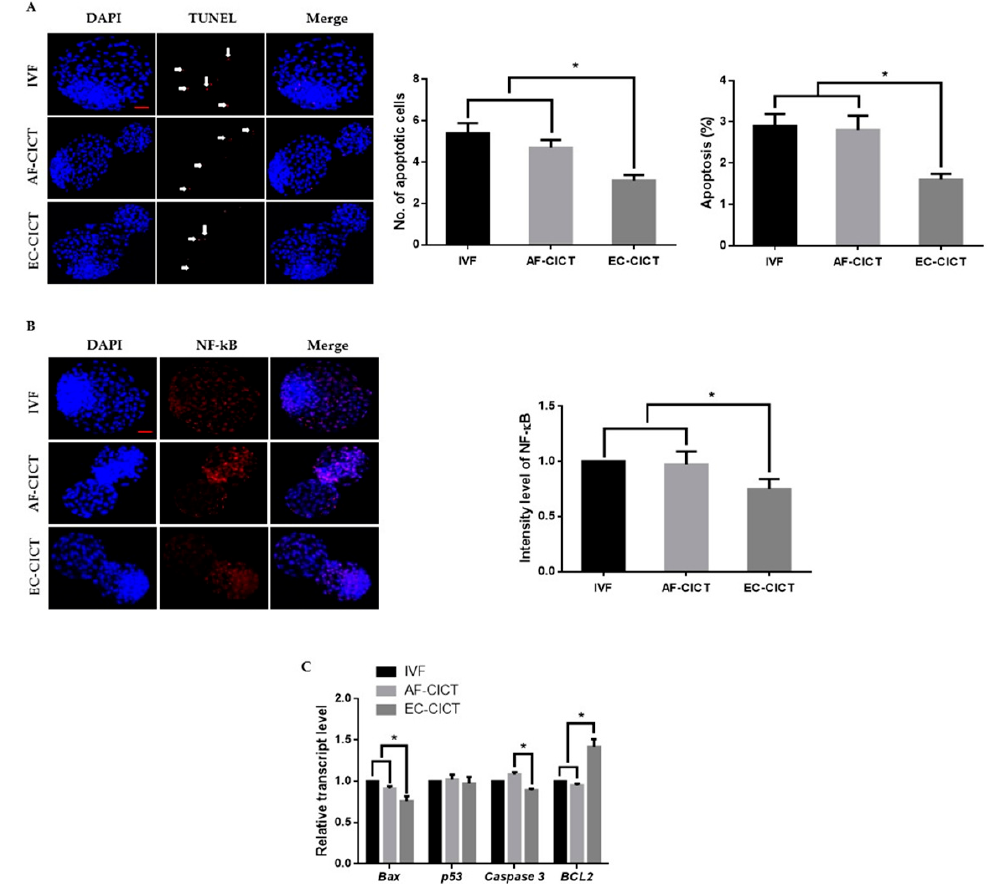
Figure 3. Incidence of apoptosis in blastocysts. ( A ) Terminal deoxynucleotidyl transferase dUTP nick end-labeling (TUNEL) assay of blastocysts. Embryos were stained for TUNEL (red, white arrow) and DNA (DAPI, blue). Bar = 100 µ m. Quantification of the number and proportion of apoptotic cells ( n = 10 per group). ( B ) Representative immunofluorescence images of NF- κ B in CICT embryos at the blastocyst stage. Embryos were stained for NF- κ B (red) and DNA (DAPI, blue). Bar = 100 µ m. Quantification of fluorescence intensity at the blastocyst stage ( n = 10 per group). ( C ) RT-qPCR results for apoptosis-related genes in blastocysts ( n = 5 per group). Labeling intensity was expressed relative to that of the IVF group (set as 100%). The data are from three independent experiments and are means ± SEM (* p < 0.05).